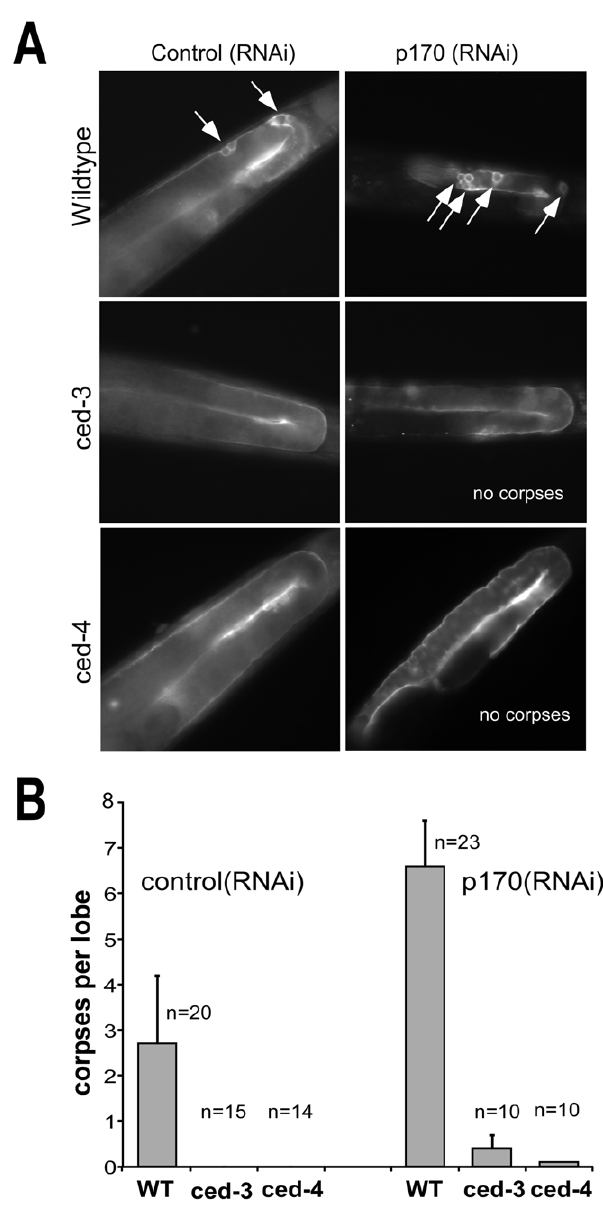
Figure 8. IFG-1 p170 depletion induces apoptosis that requires the caspase and apoptosome. (A) Fluorescence images of Control (RNAi) and p170 (RNAi)-treated adults from wild type, ced-3 (n2452) and ced-4 (n1162) strains expressing the apoptotic marker CED-1::GFP. Worms were fed E. coli expressing the dsRNA corresponding to each RNAi target, and the gonads of young adult F1 offspring (similarly fed) were analyzed by fluorescence microscopy. White arrows indicate GFP positive apoptotic germ cell corpses. (B) Bar graph depicting quantitative comparison of germ cell apoptosis induced by ifg-1 p170 mRNA depletion based on number of GFP-decorated corpses per lobe of the gonad. ‘n’ refers to number of adult gonad lobes in which corpses were counted. Error bars display